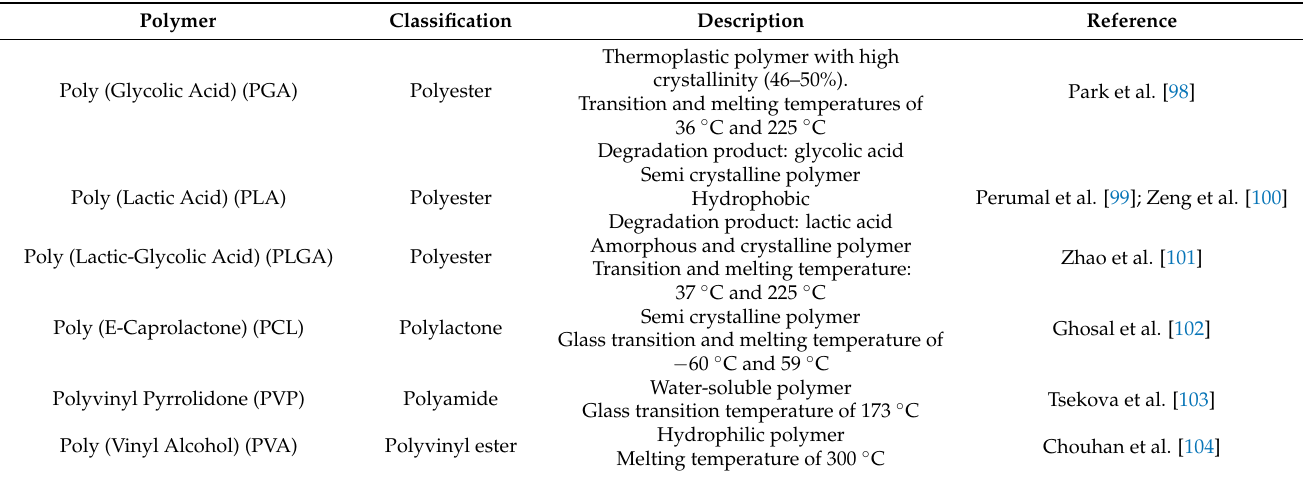
Table 2. Synthetic polymers used for nanofibers